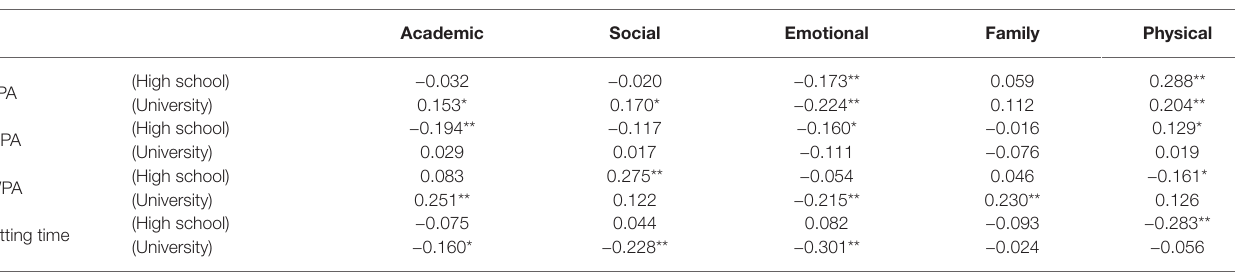
TABLE 2 | Correlational